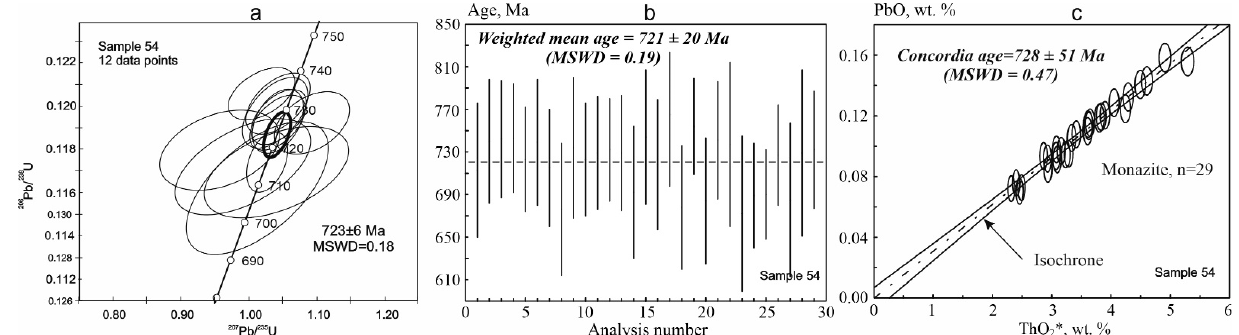
Figure 24. ( a ) Concordia diagram for zircons from granites of the Chernorechensky massif, ( b ) Th-U-Pb weighted mean ages for single data points in monazite calculated from the weighted mean compositions and the age equation of [87], and ( c ) the concordia age for the population of data on PbO/ThO 2 * (ThO 2 plus the equivalent of UO 2 ). Ellipse is the 2 σ error values calculated by propagating the analytical uncertainty on trace element compositions through the age equation, representing the short-term analytical precision as noted by [87]; dashed lines are regressed isochrones with two symmetrical hyperboles, which fixed errors.